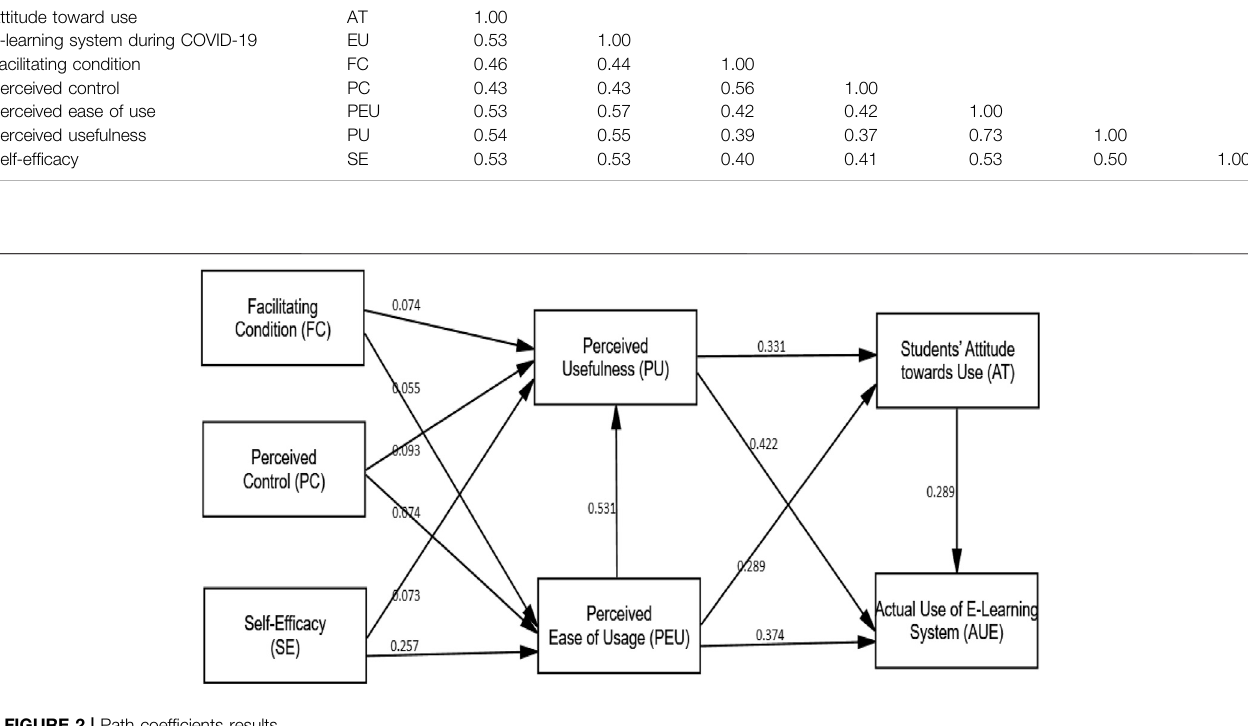
FIGURE 2 | Path coef fi cients results.